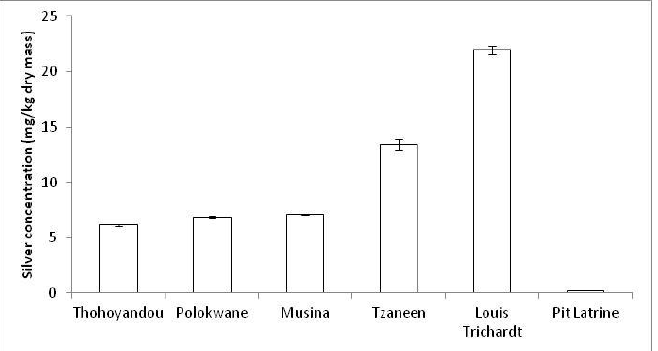
Figure 2. Concentrations of silver (mg/kg dry mass) in sludge for each municipality.